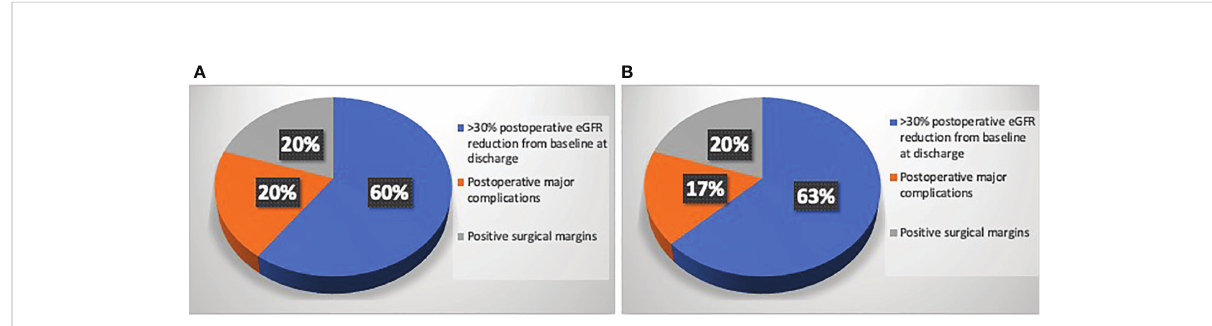
FIGURE 2 (A) Causes of Trifecta ’ s failure in patients underwent PN in Study group who did not reach the Trifecta (n=18/91); (B) Causes of Trifecta ’ s failure in patients underwent PN in Control group who did not reach the Trifecta